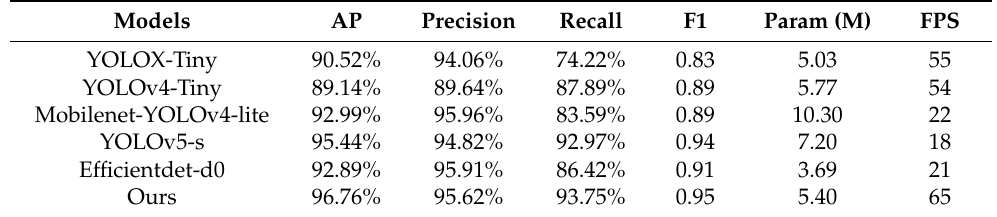
Table 4. Comparison of ShufflenetV2-YOLOX with other lightweight networks. Models